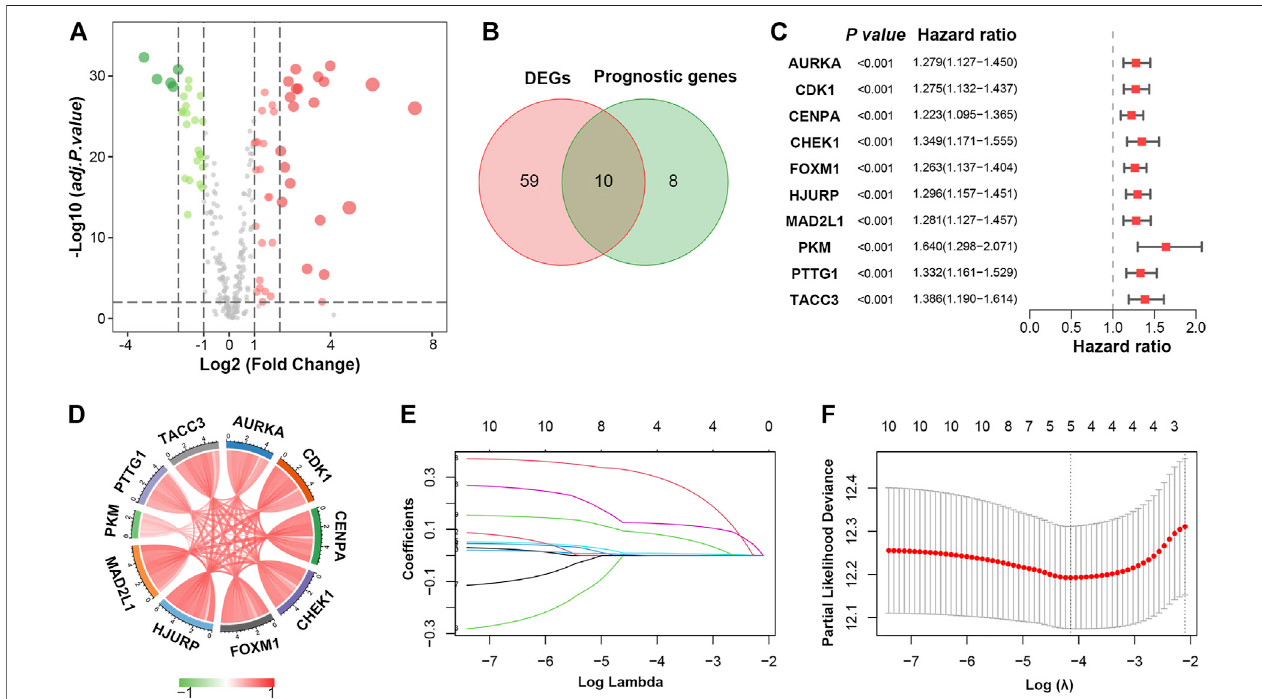
FIGURE2| Identi fi cationofprognosticcellularsenescence-relatedDEGs. (A) .Volcanoplotofcellularsenescence-relatedgenesinTCGAdatabase;redandgreen nodesindicateupregulatedanddownregulatedgenes,respectively. (B) .Venndiagramshowing10overlappinggenesinDEGsandprognosticgenes. (C) .Forrestplotof the univariate Cox analysis of 10 overlapping genes. (D) . Correlation network of 10 candidate genes. (E) . LASSO coef fi cient pro fi les of 10 candidate genes. (F) . Cross- validation for tuning parameter selection in the LASSO regression.